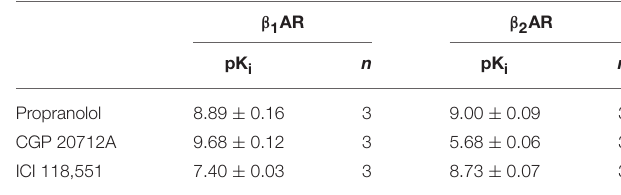
TABLE 2 | Affinity of compounds measured at the β 1 AR and β 2 AR: Affinity values for β -adrenoceptor ligands measured in CHO cells expressing the β 1 AR or the β 2 AR using 10nM of BODIPY-TMR-CGP in the HTS format fluorescent ligand binding